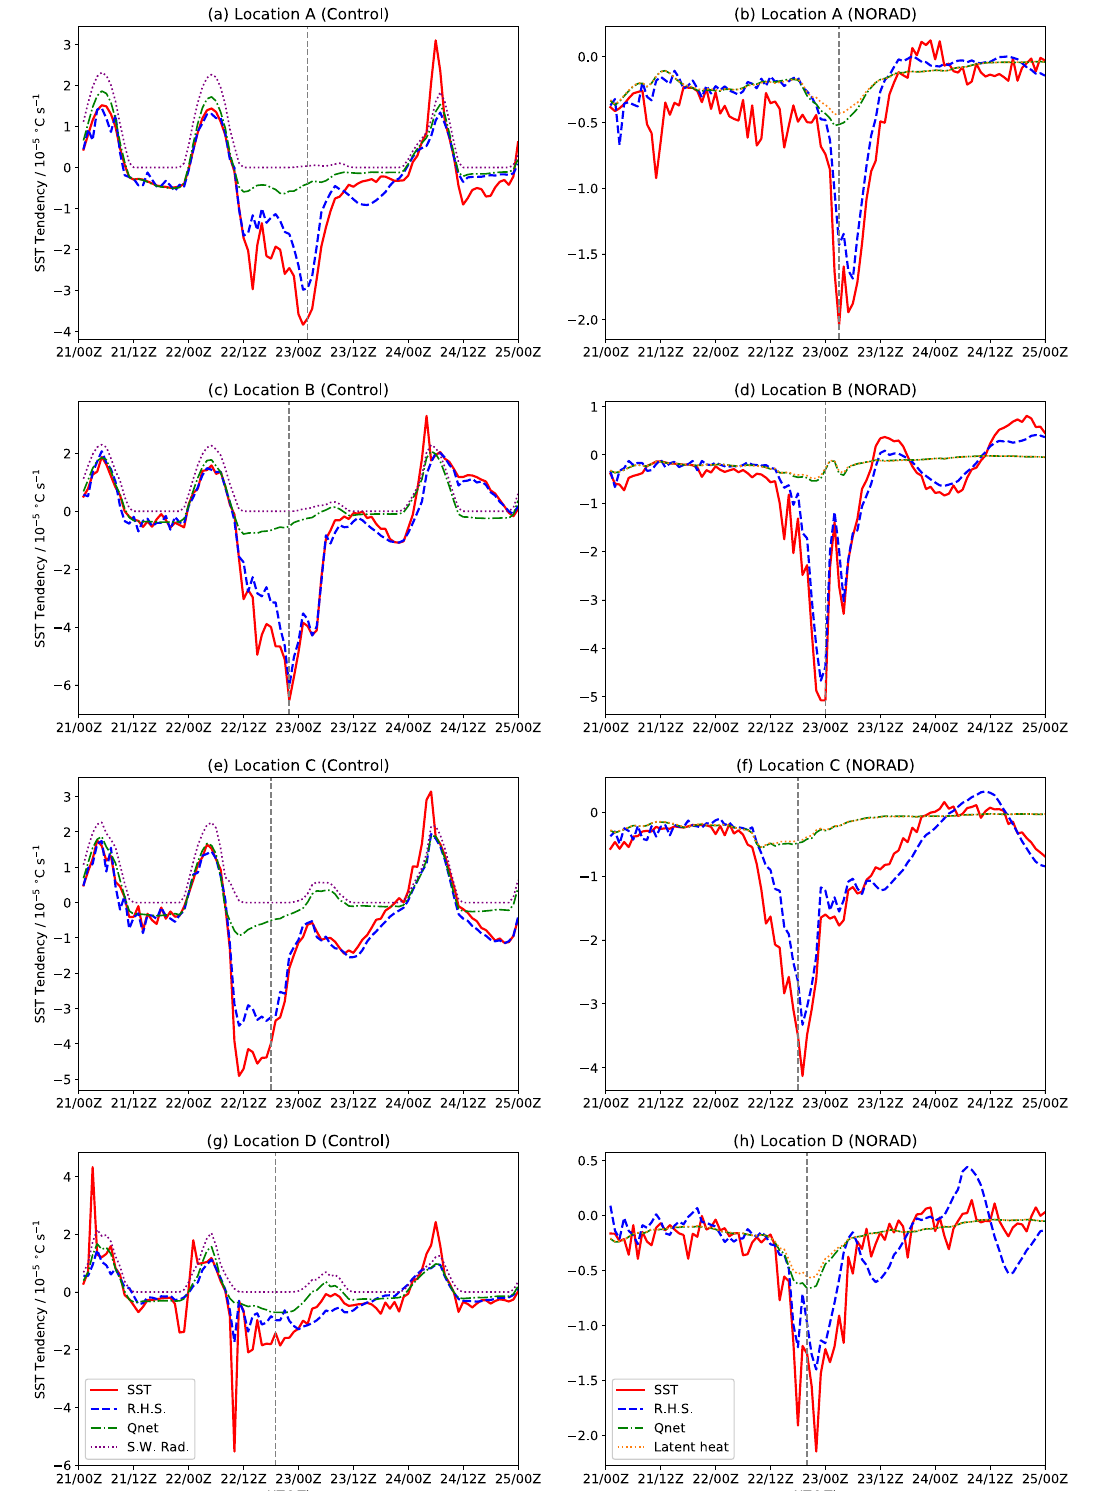
Fig. 4 Time series of various terms in the SST tendency equation. Time series of ocean mixed layer temperature change rate (red solid), the sum of right- hand side of Eq. 1 (blue dashed), net air-sea heat fl ux Q net (green dotted), shortwave radiative heating (purple dash-dotted) and latent heat fl ux (orange dash-dotted) from the a , c , e , g control and b , d , f , g NORAD experiments of Typhoon Hato at locations a , b A, c , d B, e , f C and g , h D speci fi ed in Fig. 2a. Units are in 10 − 5 °C per second, and positive (negative) indicates heat gain (loss) by the ocean. Gray dashes indicate Typhoon Hato ’ s closest time of